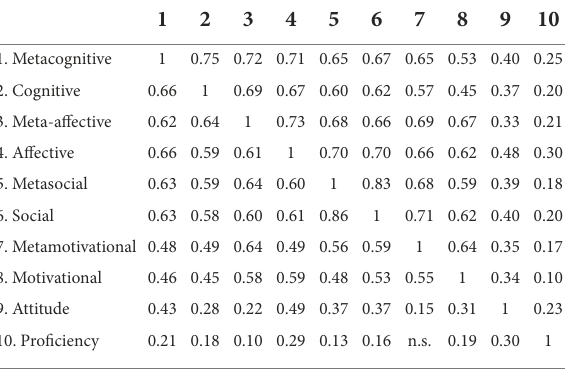
TABLE 5 Correlation coefficients for the SRFLLSQ questionnaire fields, attitude and proficiency for the two